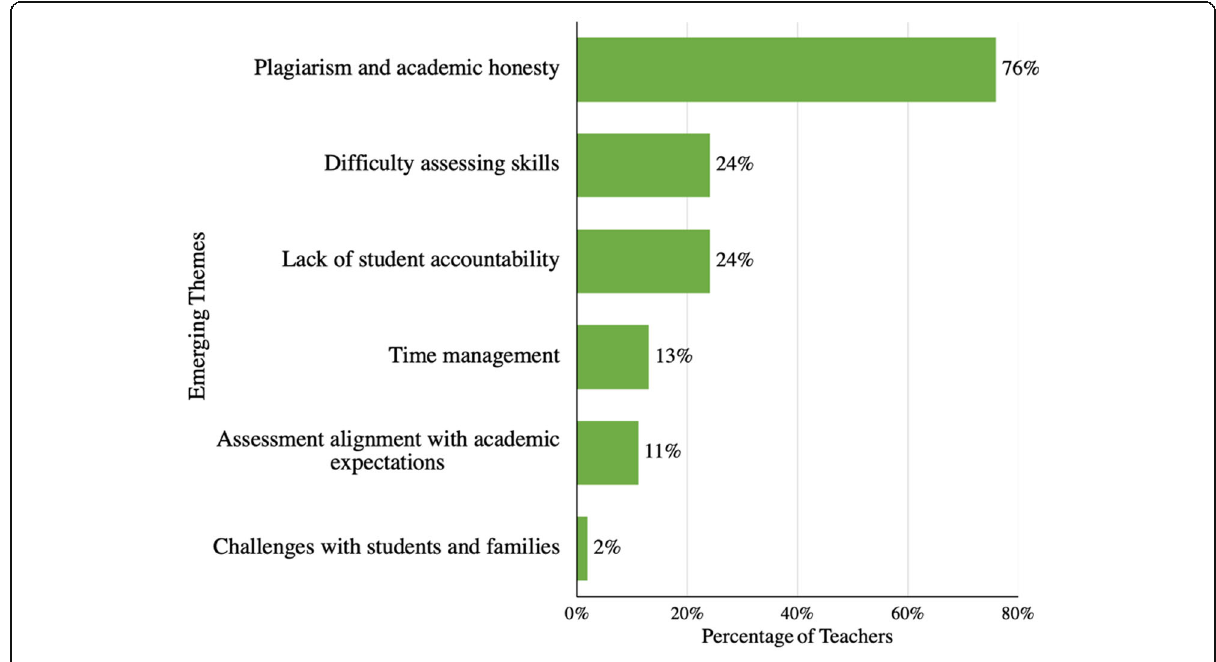
Fig. 4 Themes related to reasons for ineffective online assessment strategies